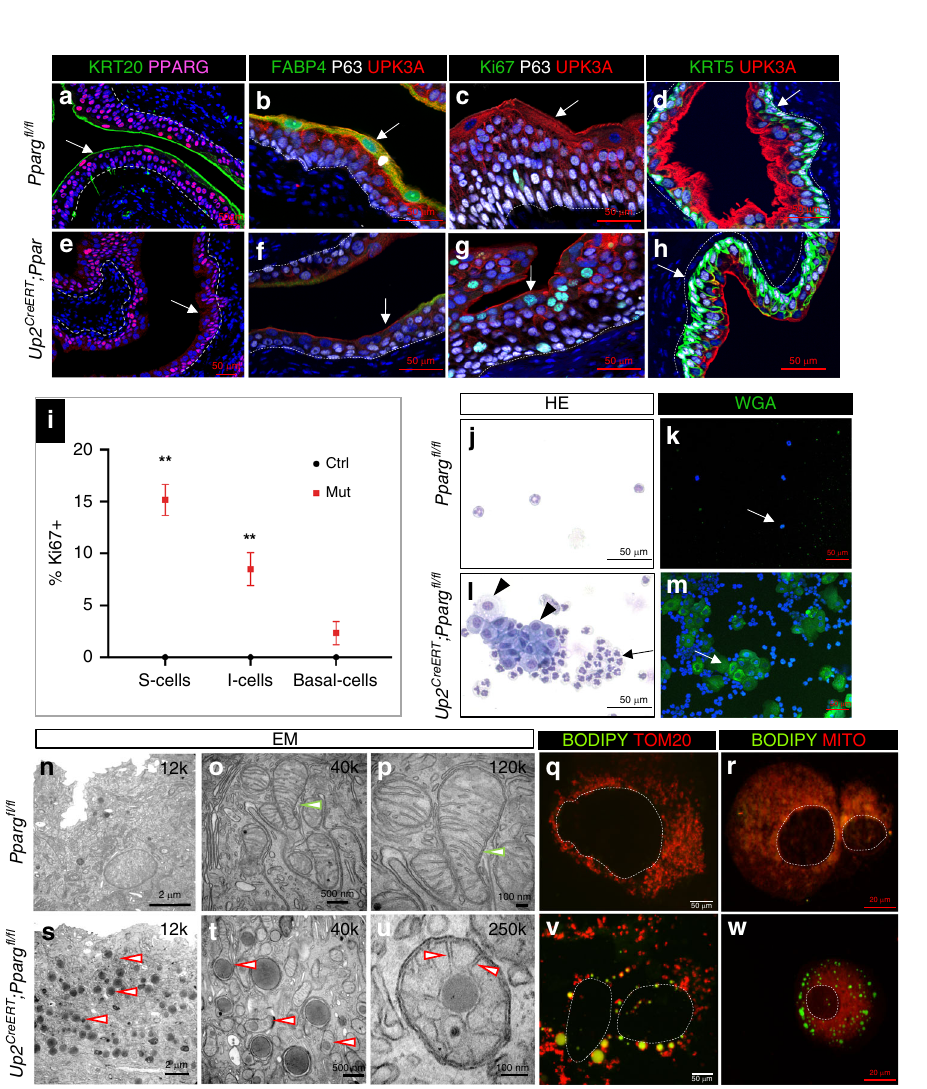
Fig. 7 Pparg is required for S cell differentiation. a – h Analysis of the urothelium from adult Pparg fl / fl control mice and Up2CreERT;Pparg fl / fl mutant mice. a , e Krt20 and Pparg expression. b , f Fabp4, P63, and Upk3a expression. c , g Ki67, P63, and Upk3a expression. d , h Krt5 and Upk3a expression. Dotted lines represent the basement membrane. White arrows point to S cells. i Quanti fi cation of Ki67 + cells in the urothelium of adult Pparg fl / fl control and Up2CreERT;Pparg fl / fl mutants. A minimum of three independent experiments were performed, and numbers are means of percentages ± SEM. Signi fi cance calculated by a two-tailed Student ’ s t test; ** p < 0.01. j , l H/E-stained urothelial cells collected from the urine of ( j ) Pparg fl / fl controls and ( l ) Up2CreERT; Pparg fl / fl mutants. Urothelial cells collected from the urine of Pparg fl / fl control ( k ) or Up2CreERT;Pparg fl / fl mutants ( m ) after prestaining with WGA-A488. Scale bars: a – m : 50 μ m. Transmission electron microscopy (2 μ m) of S cells from Pparg fl / fl controls ( n ) and a Up2CreERT;Pparg fl / fl mutant ( s ). Images (500 μ m) of mitochondria in S cells of a Pparg fl / fl control ( o ) and Up2CreERT;Pparg fl / fl mutant ( t ). Images (100 nm) of mitochondria in S cells of controls ( p ) and a Up2CreERT;Pparg fl / fl mutant ( u ). Green-white arrowheads in ( o , p ) denote mitochondria. Red-white arrowheads in ( s , t ) denote mitochondria with inclusions. Red-white arrowheads in u denote the position of the inclusion body, which is in the intermembrane space. q , v Urothelial cells from adult Pparg fl / fl controls and Up2CreERT;Pparg fl / fl mutants stained with BODIPY and TOM20. r , w Cytospin prep of urothelial cells from an adult Pparg fl / fl control and a Up2CreERT;Pparg fl / fl stained with BODIPY and Mitotracker. Dotted line denotes the nucleus in q , r , v , and w . Samples in the analysis: Adult urothelium isolated during homeostasis: Up2CreERT;Pparg fl / fl mutants, n = 8; Pparg fl / fl controls, n = 7. WGA staining and EM were each performed with n = 3 samples from mutants and controls. Scale bar: q , r 5 μ m, v , w 20 μ m. Source data are provided as a Source Data fi